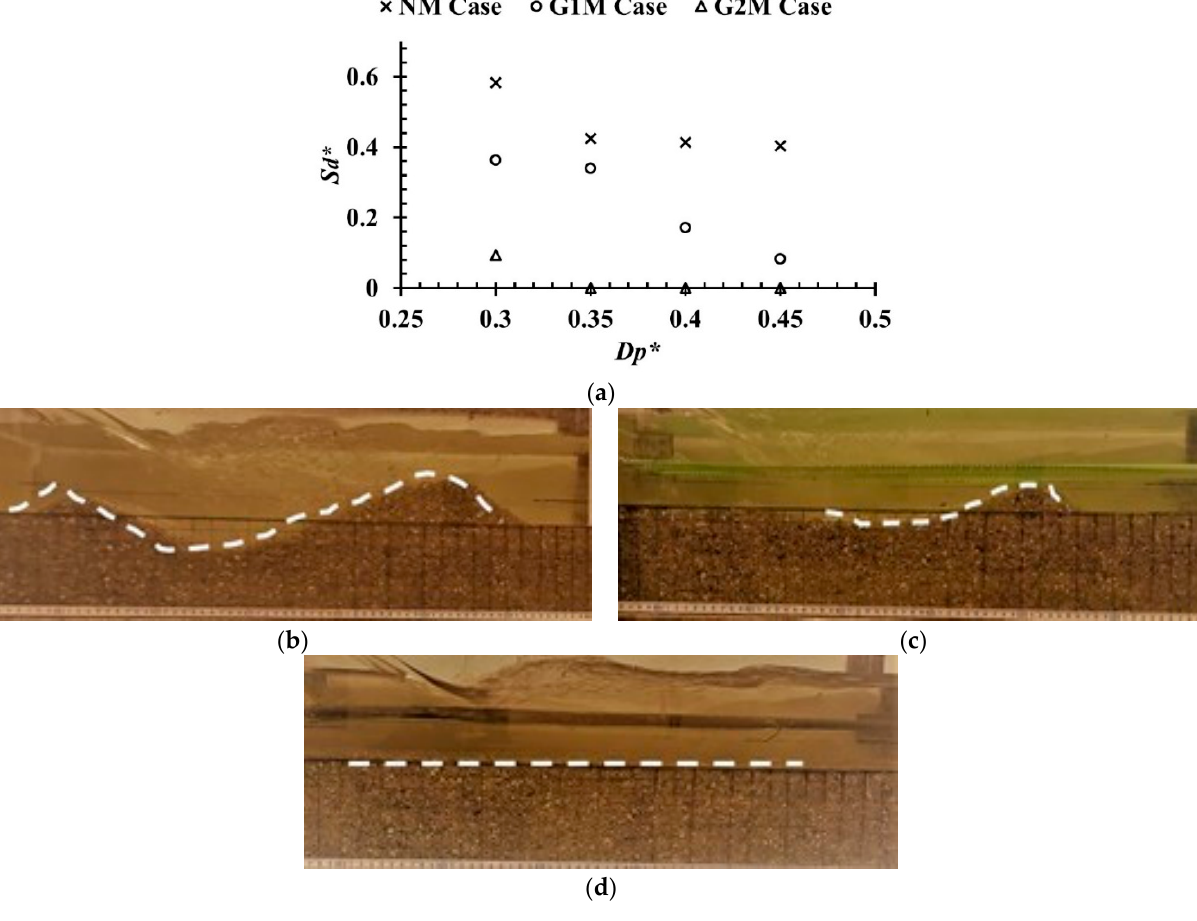
Figure 9. ( a ) Relation between maximum scour depth ( 𝑺 𝒅 ) and 𝑫 𝒑 ∗ at 𝑫 𝒄 ∗ = 0.2; pictorial view of scour profile ( b ) during NM Case ( 𝑫 𝒑 ∗ = 0.45; 𝑫 𝒄 ∗ = 0.2); ( c ) G1M case ( 𝑫 𝒑 ∗ = 0.45; 𝑫 𝒄 ∗ = 0.2); ( d ) G2M case ( 𝑫 𝒑 ∗ = 0.45; 𝑫 𝒄 ∗ = 0.2).